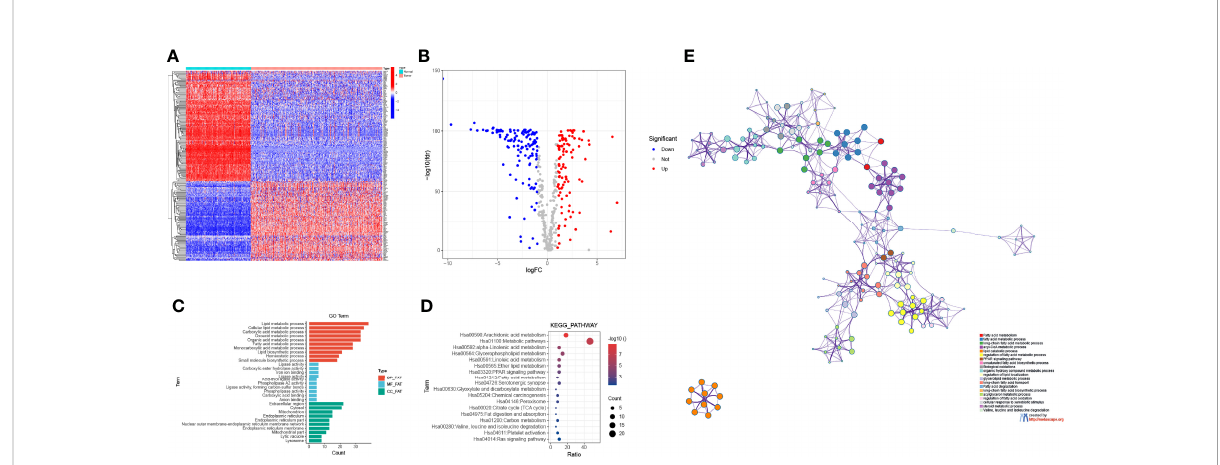
FIGURE 2 Identi fi cation of DEFAMGs in the TCGA cohort. (A) Heatmap of DEFAMGs. (B) Volcano plot of DEFAMGs. (C) GO enrichment analysis of DEFAMGs, showing only the fi rst 10 terms respectively in the BP, MF and CC. (D) KEGG enrichment analysis of DEFAMGs, showing top 18 Fatty acid metabolism-related pathways. (E) Metascape displayed the functional enrichment network of fatty acid metabolism.